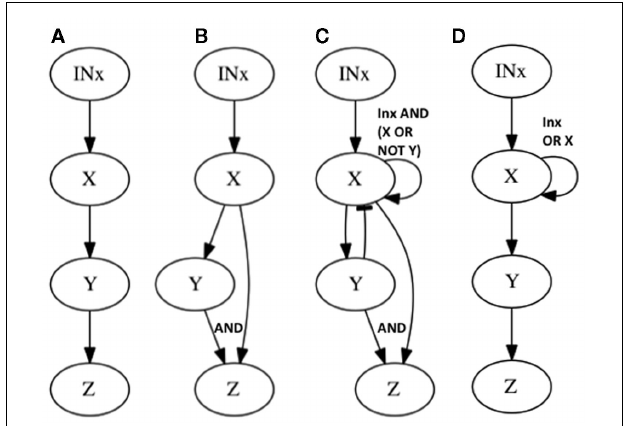
FIGURE 3 | Subgraphs to be inferred with epistasis analysis. The graphs of the examples explained in the main text are shown. All these subgraphs yield the same results with a classical epistasis analysis. IN x (Input of X ) is included to meet assumptions 1, 2, and 3 of epistasis analysis, but it could be obviated, as it is commonly done. According to Huang and Sternberg (2006) we can call such cases to be “substrate dependent pathways,” and we can only order genes in this kind of pathways through epistasis when they do not display the same mutant phenotype.The logical rules for each motif are: (A) x = IN, y = x , z = y , (B) x = IN x , y = x , z = x ∧ y , z = y , (C) x =